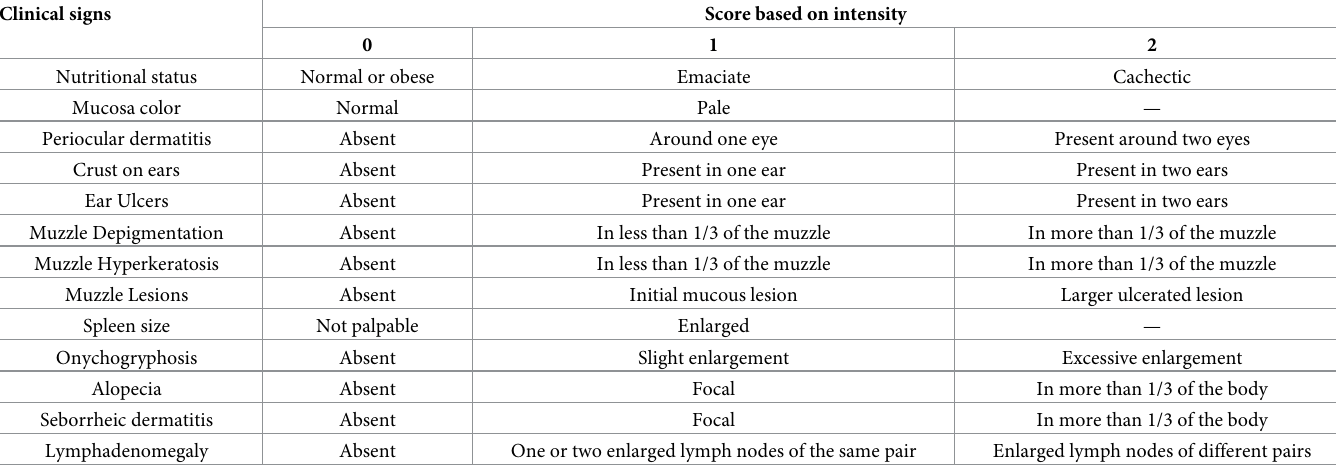
Table 1. Canine visceral leishmaniasis clinical parameters employed to calculate the clinical score of each animal included in the study. Clinical signs Score based on intensity Nutritional